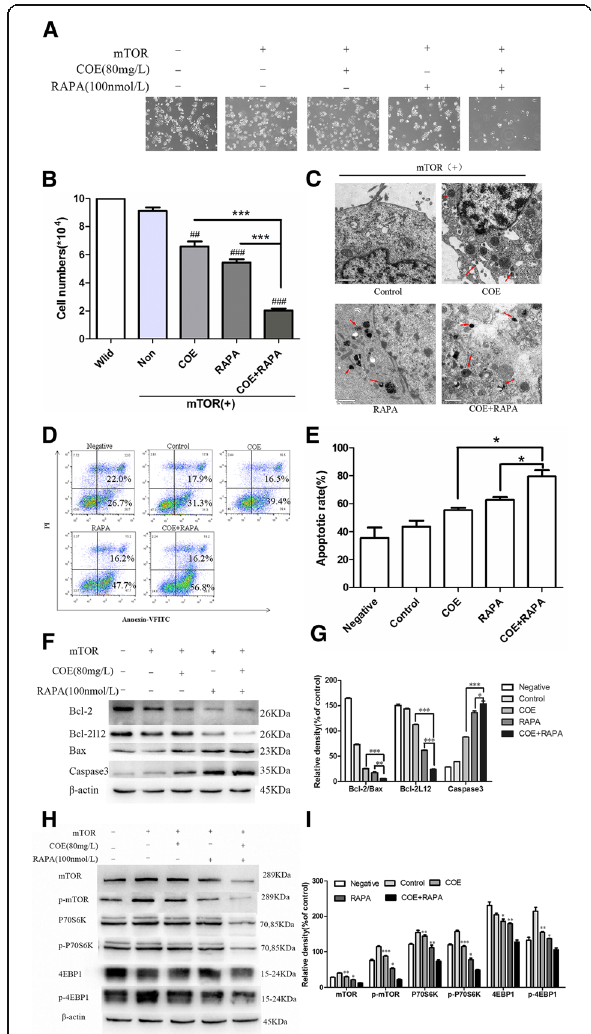
Fig. 6 Effects of the combined treatment of RAPA and COE. The HepG2/mTOR + cells were treated with 0.1%DMSO as solvent control, or 80 mg/L COE, or 100 nmol/L RAPA combined with 80 mg/L COE for 24 h. a and b the numbers of the HepG2/mTOR + cells were observed under inverted microscope (100×). c the morphological changes were observed under transmission electron microscope (2950×, Scale, 1 μ m); red arrows are representative of the apoptotic bodies. d and e the apoptosis was detected by Flow cytometry.